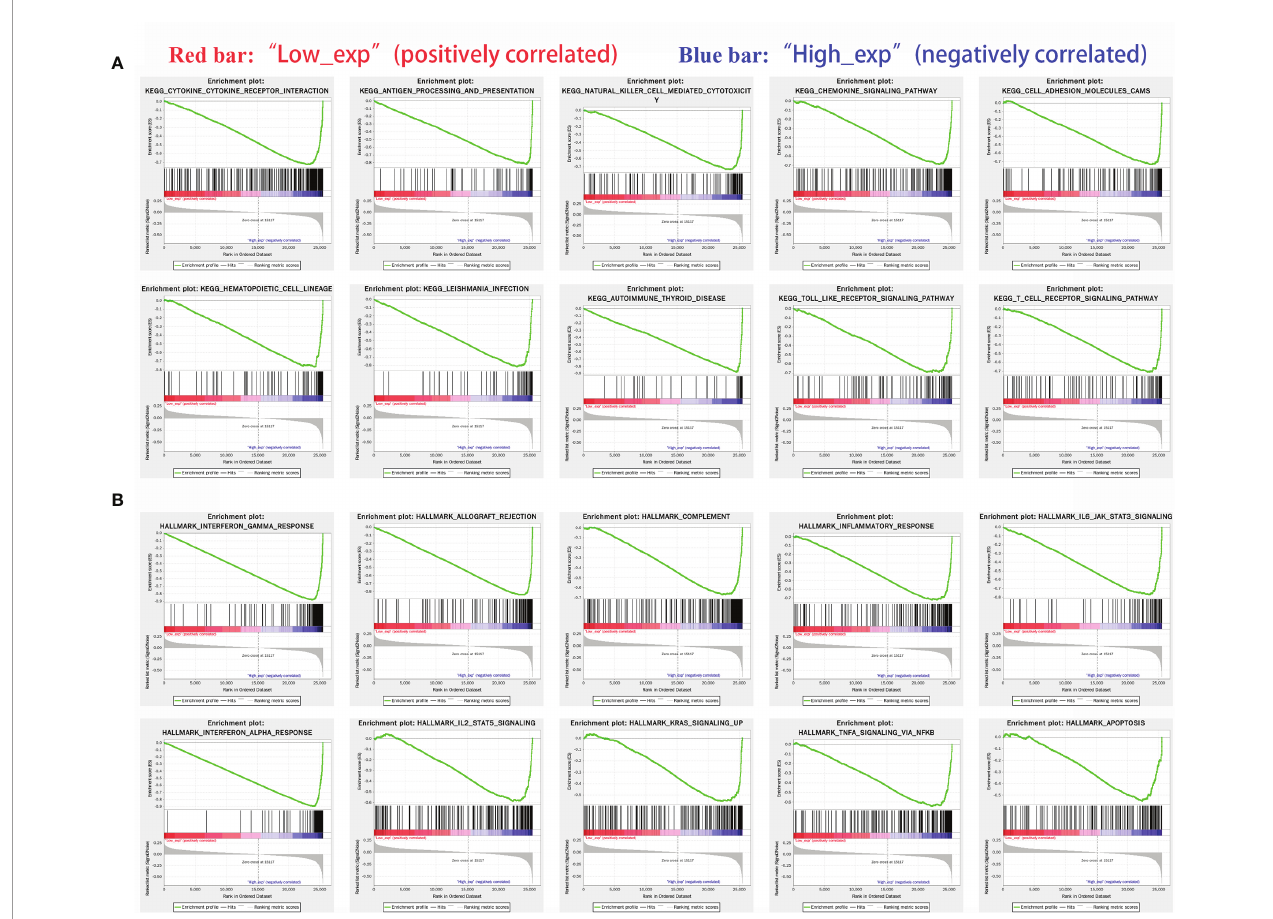
FIGURE 8 | Gene enrichment analysis of IDO1 in cancers. [ (A) Highly expressed IDO1 in KEGG enriched top ten pathway; (B) Highly expressed IDO1 in HALLMARK enriched top ten